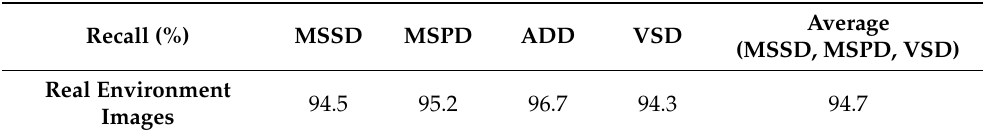
Table 2. Quantitative results for the evaluation of the object detection and localization model trained on real environmental